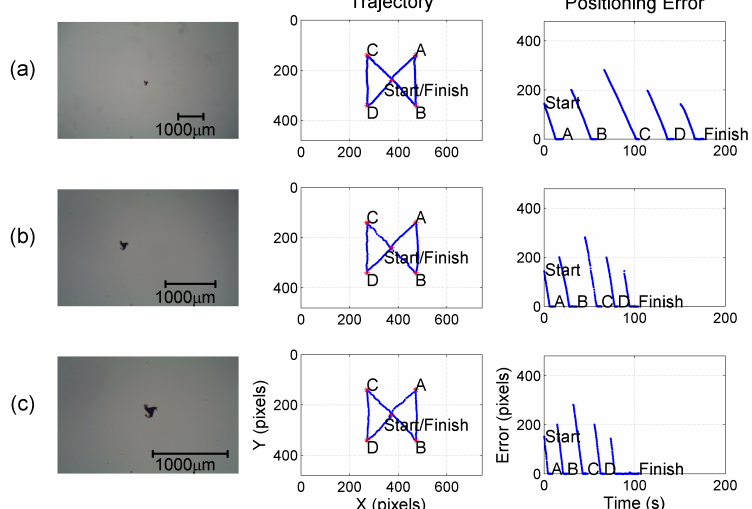
Figure 5. Point-to-point control for three different magnifications {( a ) 10×, ( b ) 20×, and ( c ) 30×} showing the image plane trajectory and the error between the goal position and the microrobot over time. The same algorithm and initial parameters were used in each